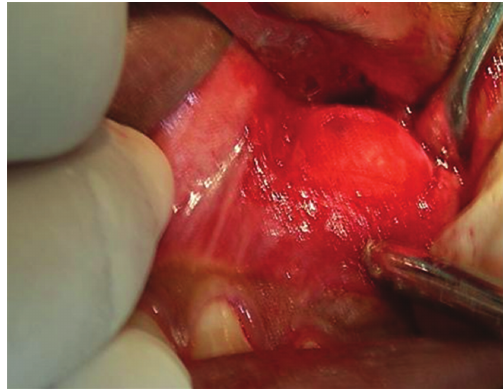
Figure 4: Intra-operative view of the